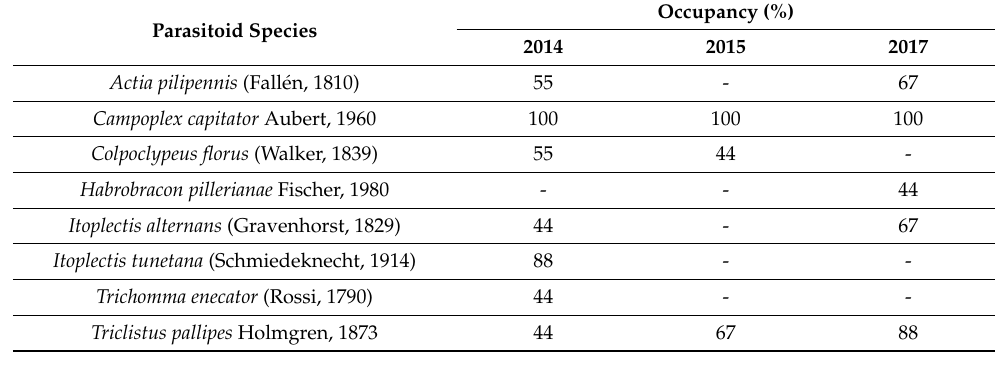
Table 2. Occupancy (%) for parasitoid species of Lobesia botrana that reached a value of at least 44% (i.e., 4 out of 9 sampled areas) during the three-year field study in Tuscany, Italy.